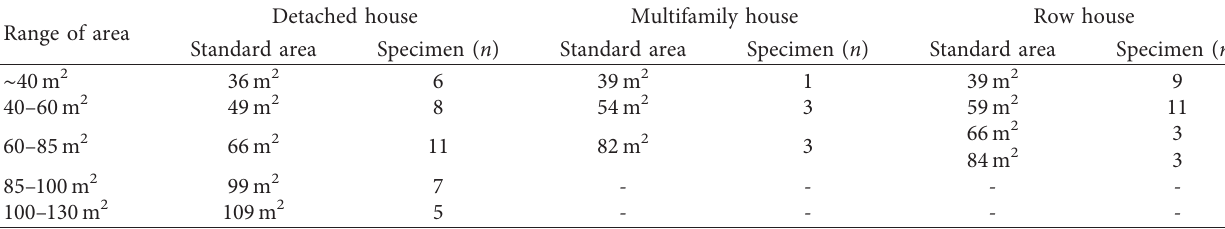
Table 13: Survey design sample according to building type and area.